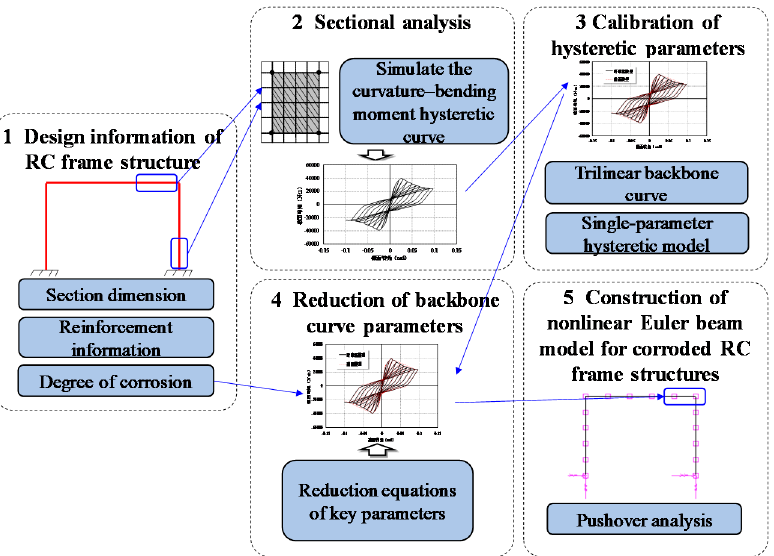
Figure 7. Simulation procedure of corroded RC frame structures.